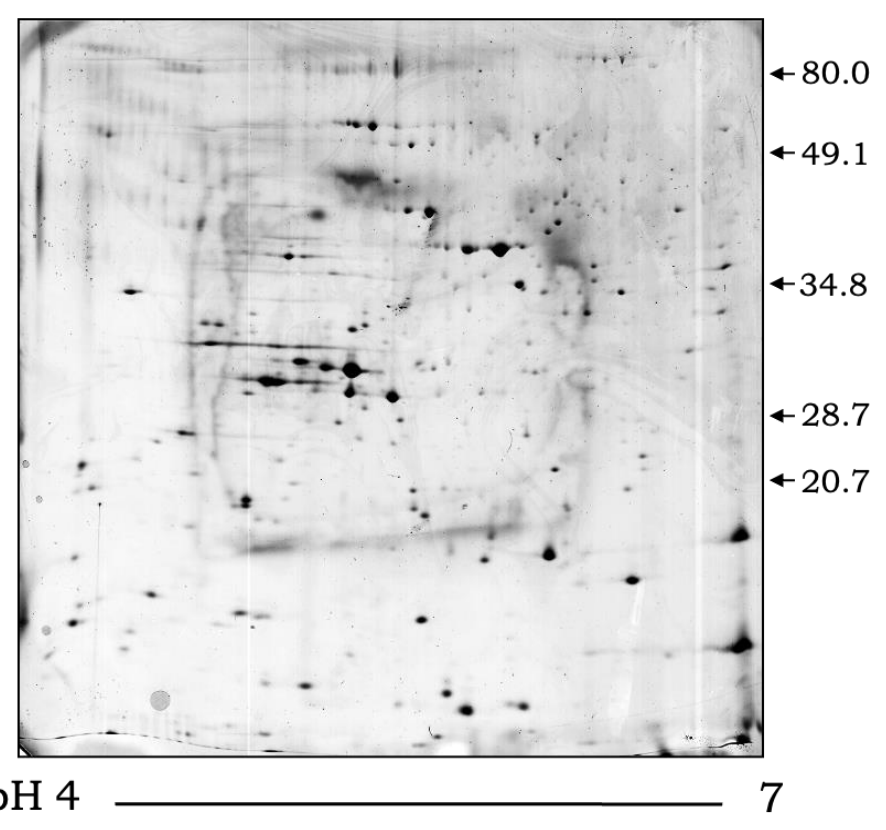
Figure 5. The 2-dimensional SDS-PAGE stained with Coomassie Brilliant Blue G-250 demonstrating the diversity of proteins extracellularly released by S. apiospermum . Molecular mass markers expressed in kilodaltons are expressed on the right.